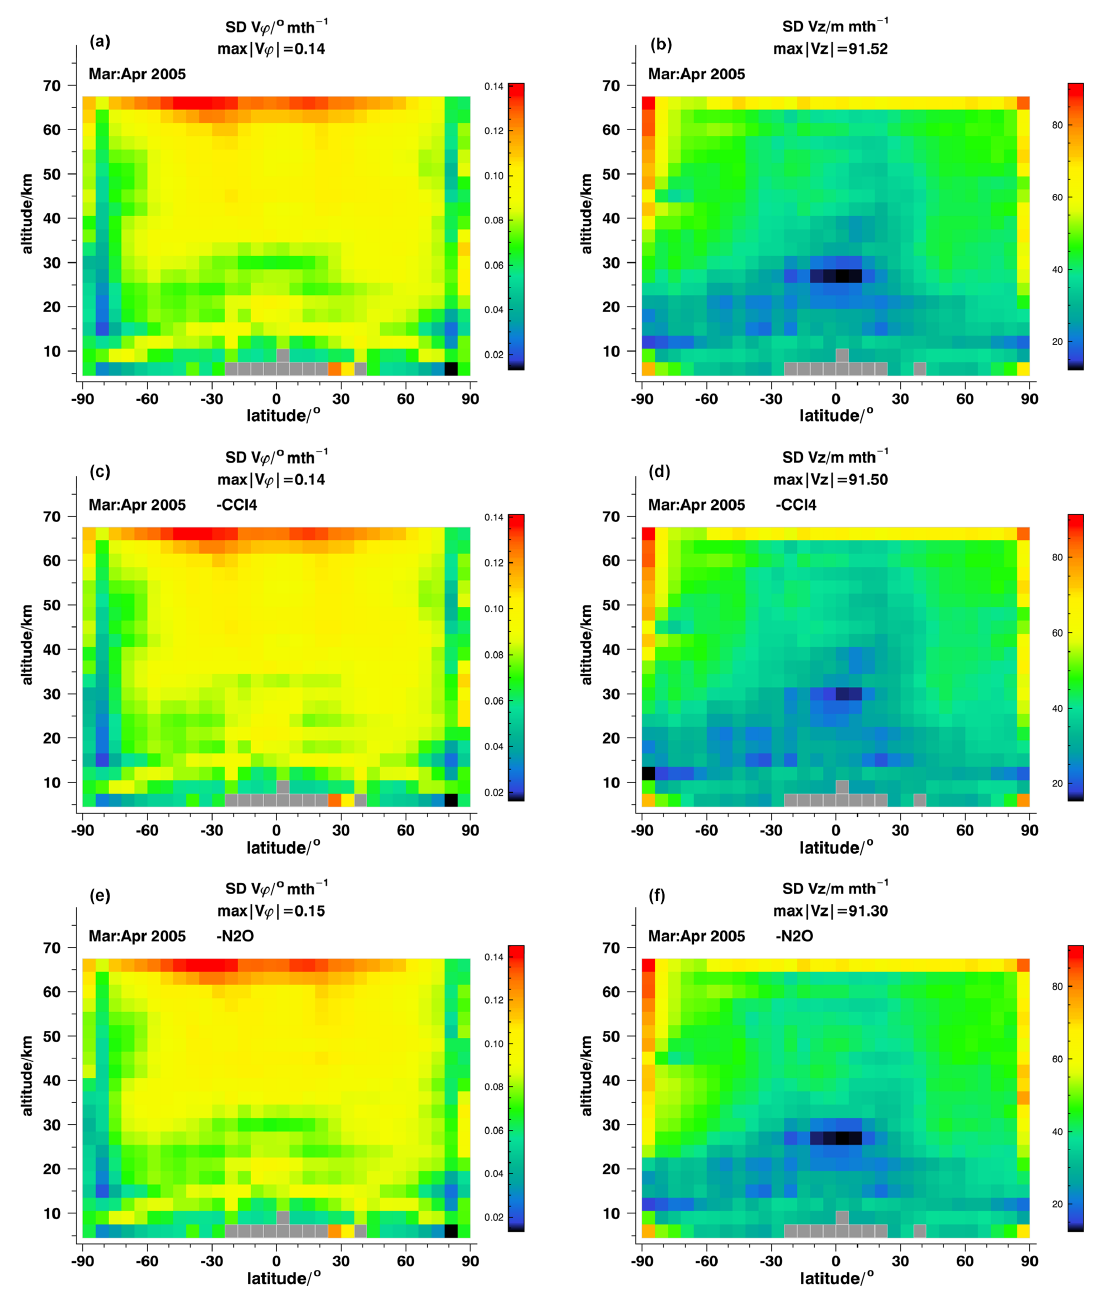
Figure 11. Estimated standard deviations of horizontal (a, c, e) and vertical (b, d, f) effective velocities for ANCISTRUS runs with all nine gases (a, b) , with CCl 4 omitted (c, d) and with N 2 O omitted (e, f) for March–April